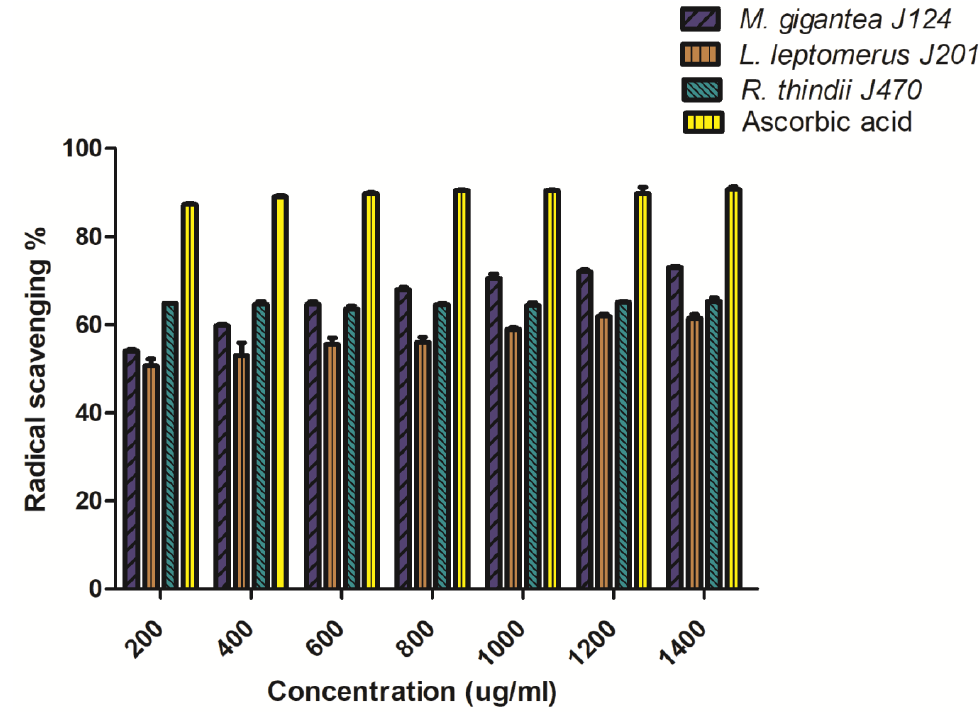
Figure 2. Comparative results of the DPPH radical scavenging percentage of methanol extract of the three wild edible mushrooms and ascorbic acid at different concentrations (mean ± SEM).